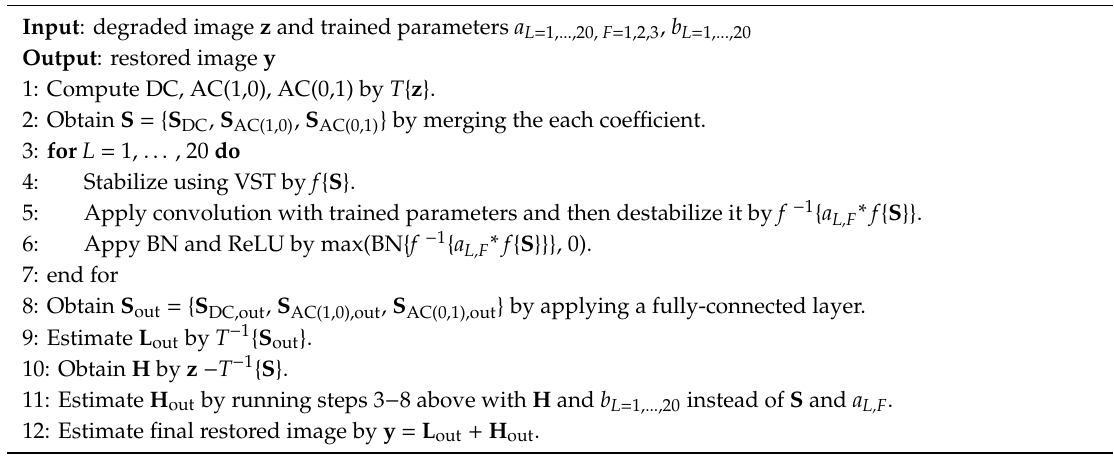
Algorithm 1: Compressed Poisson noise reduction based on the SCENet